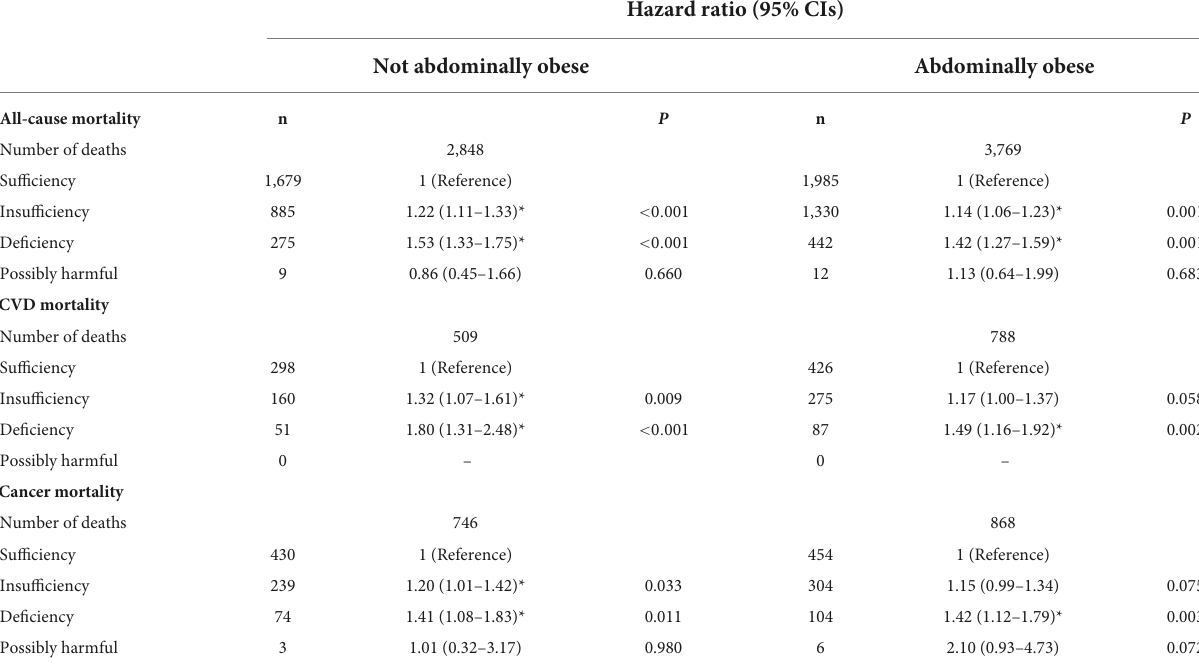
TABLE 6 Stratified HRs (95% CIs) across different WC categories and additive effect of serum 25(OH)D status on all-cause and cause-specific mortality in NHANES III and NHANES 2001–2014. Vitamin D status WC Hazard ratio (95% CIs) Not abdominally obese Abdominally